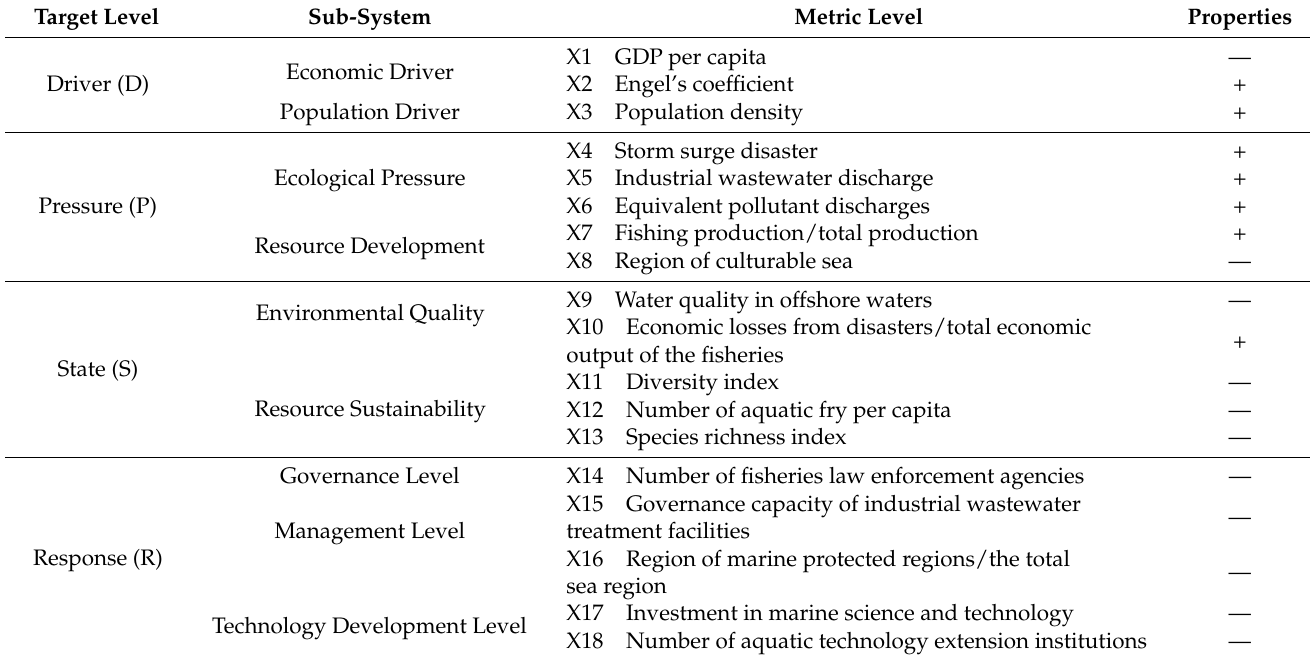
Table 1. Vulnerability evaluation indicator system for China′ s marine fisheries.